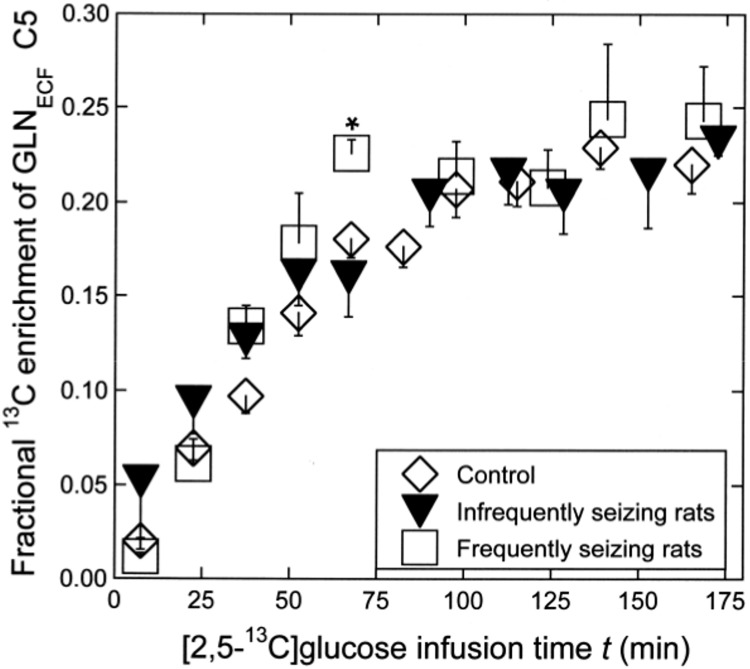
Time course of 13C enrichment of GLNECF.Time course shown as the mean ± SE for infrequently seizing rats (black inverted triangle) and frequently seizing rats (open square) compared to the control (open diamond). The error bar, when invisible, is smaller than the symbol. See text for the explanation of the significant difference at t = 67 min. The mean ± SE values of the rates of 13C enrichment of GLNECF C5 over t = 0–110 min in the three groups are shown in Table 2, as explained in the text.